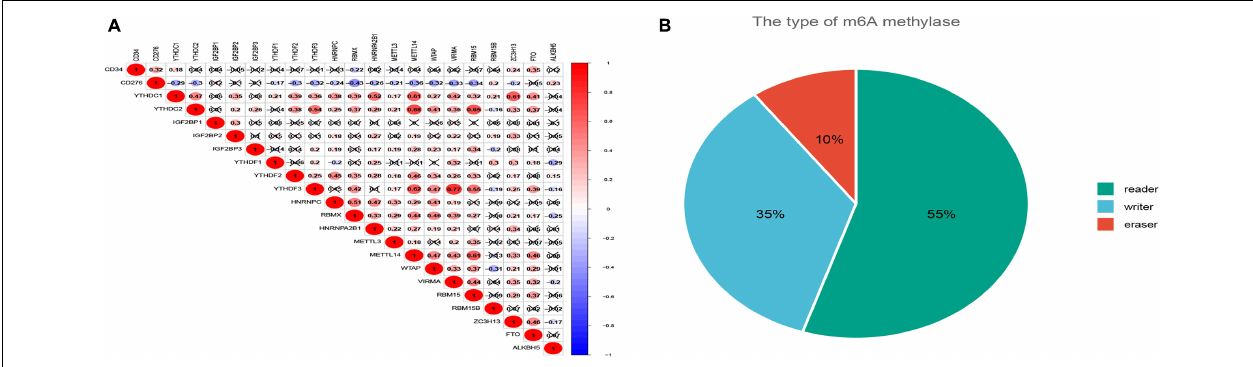
FIGURE 2 | The co-expression of CD34/CD276 and m6A regulator in CRC. (A) The expression level of CD34 was positively correlated with the expression of FTO, while the expression level of CD276 was positively correlated with the expression of ALKBH5. (B) The regulatory factors of m6A were classified by function.